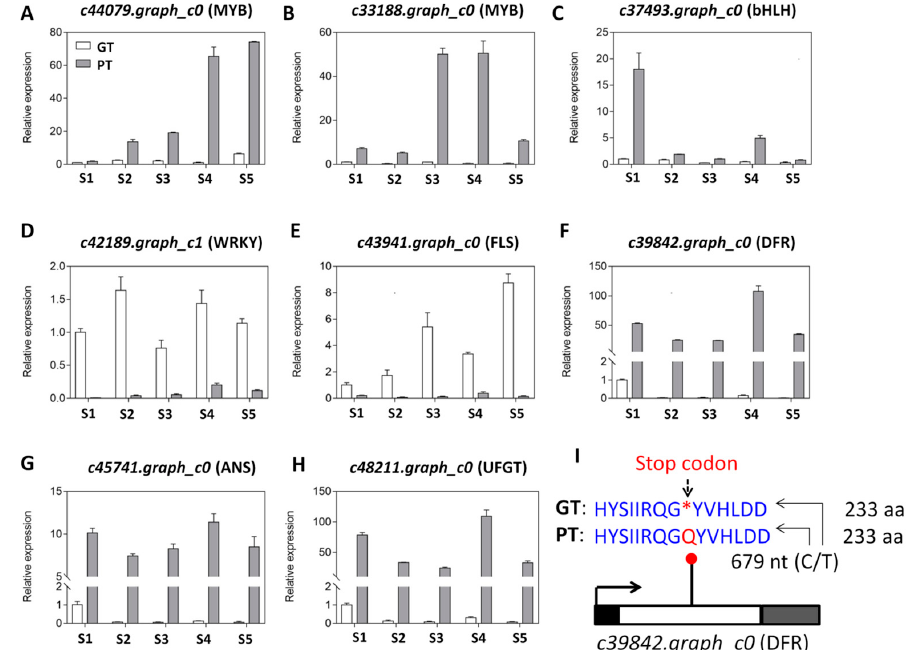
Figure 7. Quantitative real time PCR validation of selected candidate genes predicted to differentially affect the anthocyanin profiles in the two turnips. ( A–H ) Relative expression level of c33188.graph_c0 (MYB), c44079.graph_c0 (MYB), c37493.graph_c0 (bHLH), c42189.graph_c1 (WRKY), c43941.graph_c0 (FLS), c39842.graph_c0 (DFR), c45741.graph_c0 (ANS) and c48211.graph_c0 (UFGT) between PT and GT at five developmental stages (S1–S5). PT represents the purple turnip while GT represents the green turnip and are represented by the grey and white bars, respectively. The error bar represents the SD of biological replicates. The Actin gene was used as the internal reference gene for normalization; ( I ) identification of a non-sense mutation in the gene c39842.graph_c0 (DFR) by comparing the sequences between PT and GT. The single nucleotide polymorphism (C/T) is located at the position 679 within the coding sequence of the gene and is predicted to generate an amino acid (aa) Q in PT while a stop codon in GT. The white box represents the exon while the black and gray boxes represent the UTR5 ′ and UTR3 ′ , respectively. The arrow indicates the transcription start site and transcription orientation.